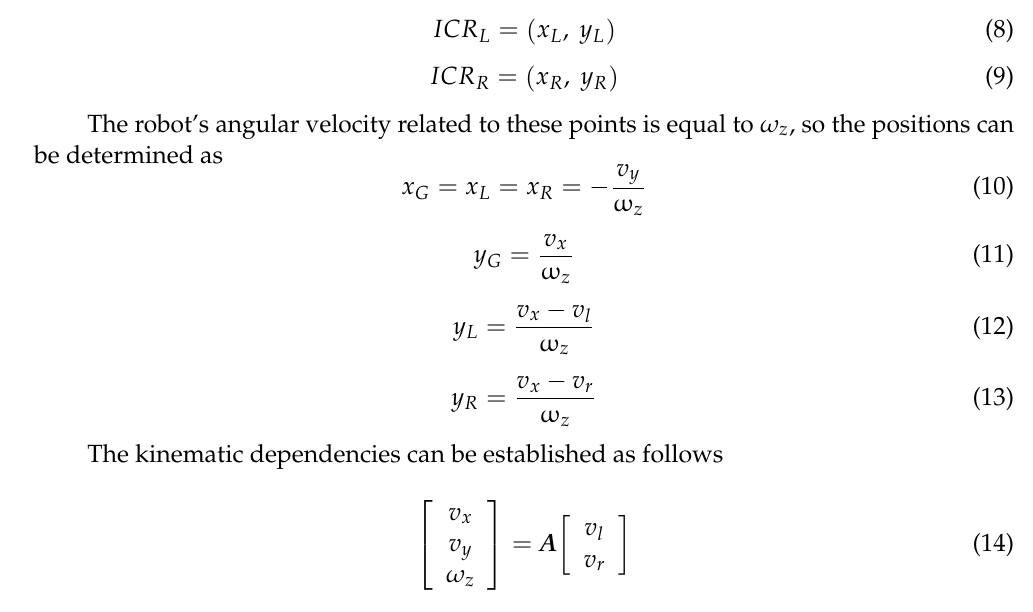
Figure 2. The 4-wheel skid-steer drive mobile robot. Assume the skid-steer robot is moving with velocity v around the point marked as ICR , the curved path radius is equal to R . On the line parallel to the Y R axis lie instantaneous centers of rotation of the left ( ICR L ) and right ( ICR R ) robot trunk side [18]. The points have following coordinates